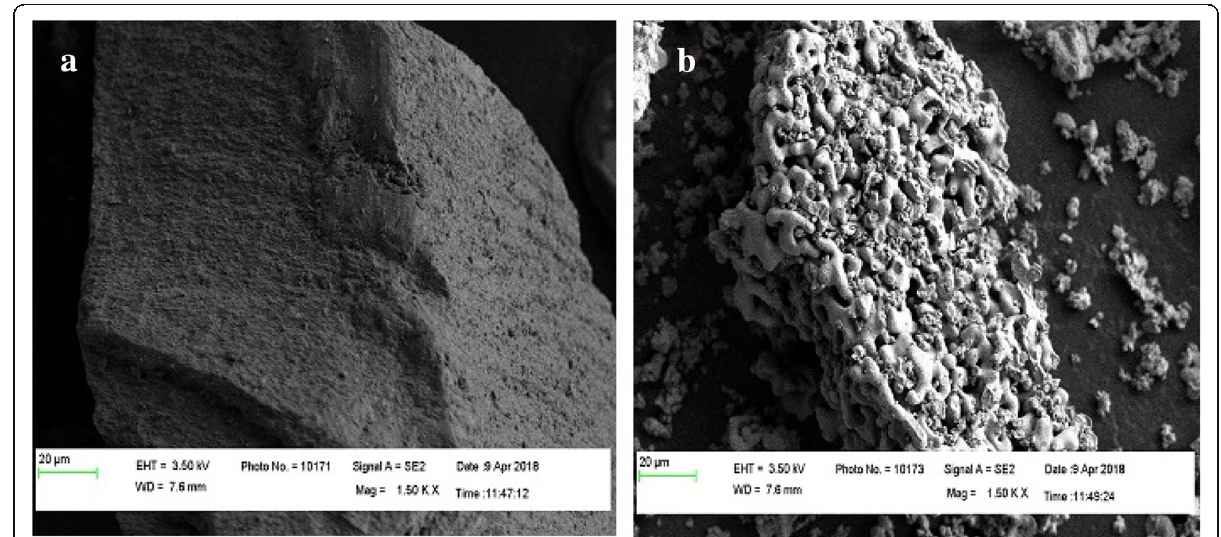
Fig. 4 SEM image of ( a ) uncalcined DDS and ( b ) calcined